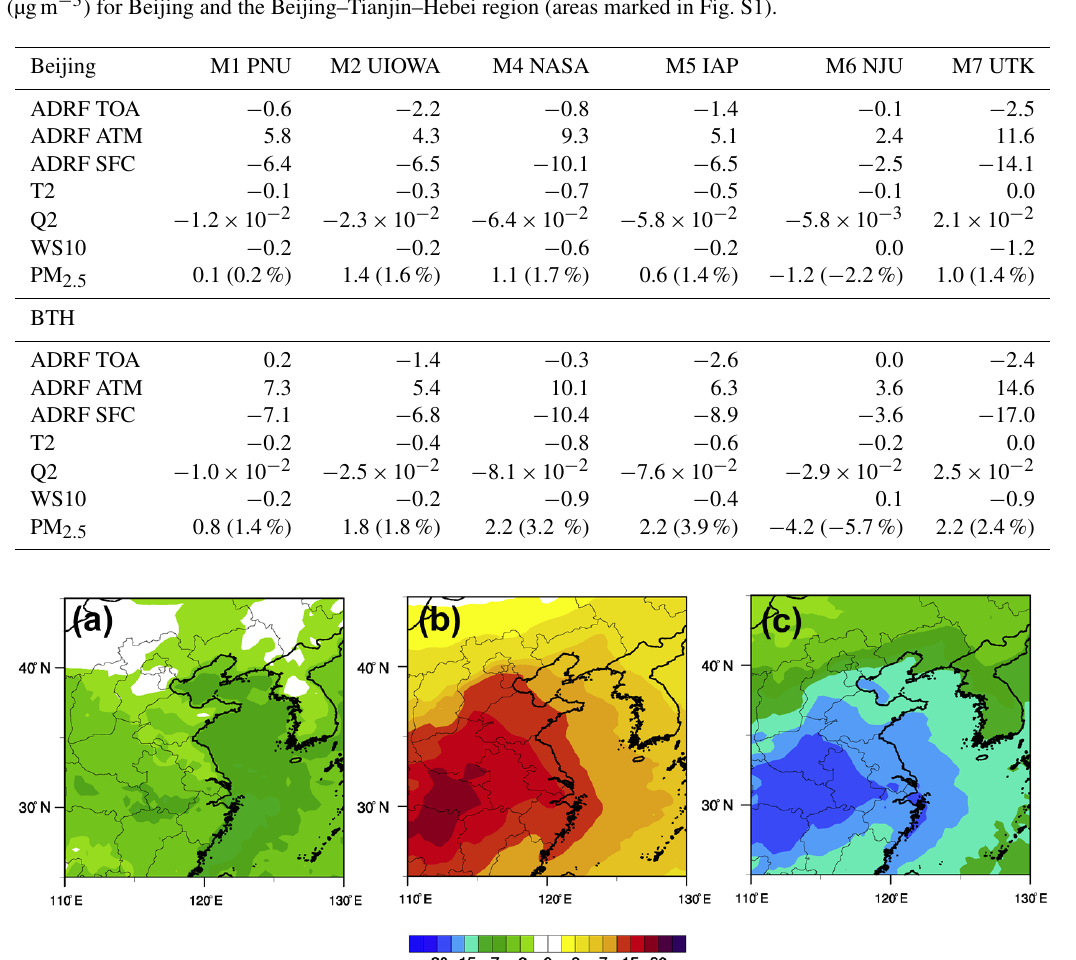
Table 2. Monthly mean (January 2010) aerosol direct radiative forcing (Wm − 2 ) and changes in T2 ( ◦ C), Q2 (gkg − 1 ), WS10 (0.1ms − 1 ), and PM 2 . 5 (µgm − 3 ) for Beijing and the Beijing–Tianjin–Hebei region (areas marked in Fig. S1).